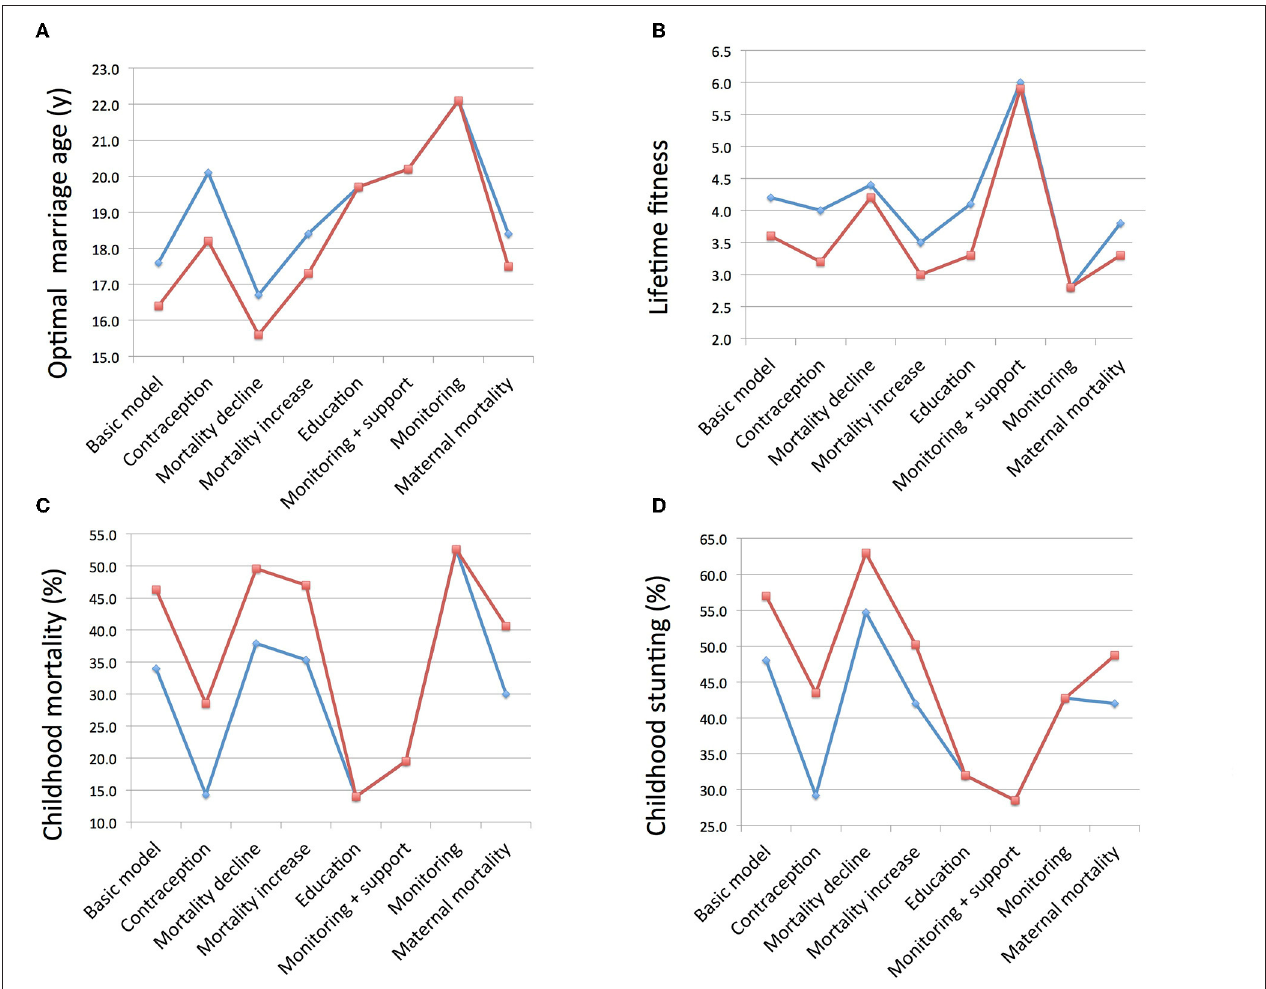
FIGURE 6 | Summary of main findings across all the models, showing values corresponding to the optimal age at marriage for women of mothers (blue) and fathers (red). (A) Optimal age at marriage. (B) Lifetime reproductive fitness calculated as the number of surviving offspring. (C) Rate of child mortality relative to all children born. (D) Rate of child undernutrition assessed in terms of